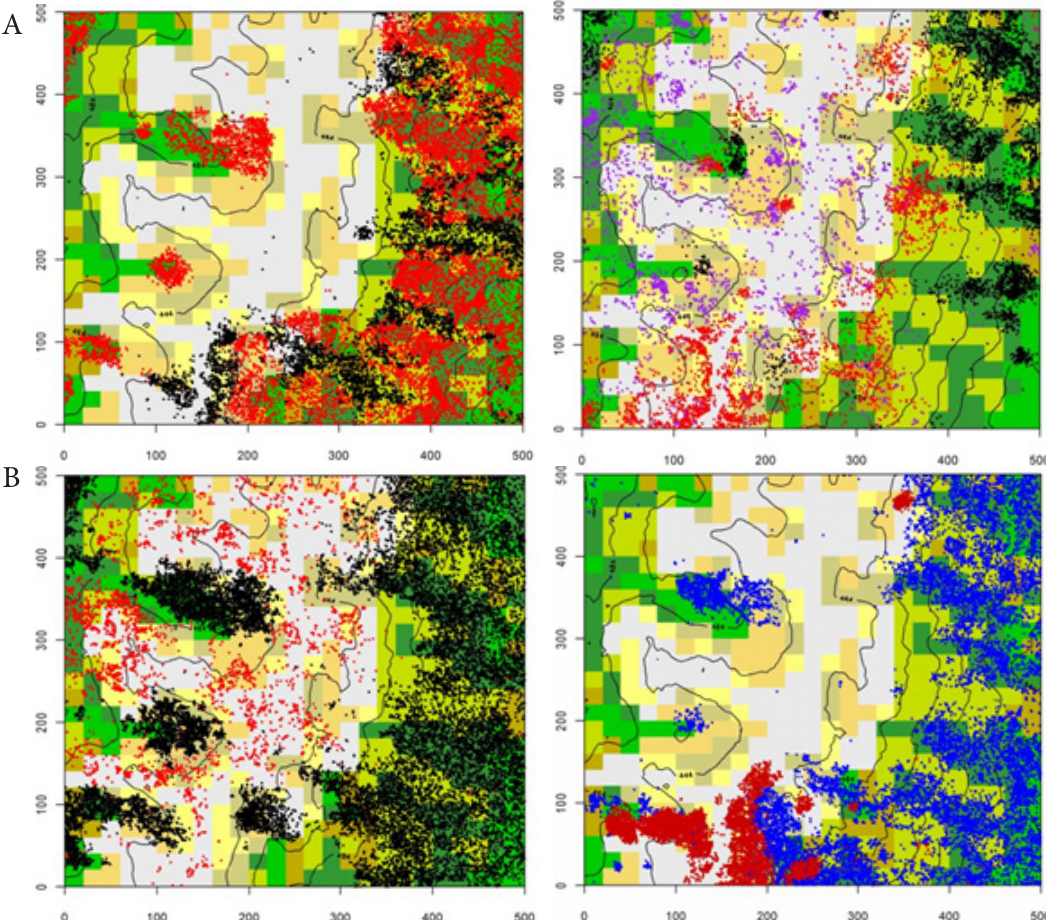
Figure 7: Spatial patterns of canopy (A) ( Mesua spp . [left], Shorea spp . [right]) and, subcanopy and treelet (B) ( Schumachaeria & Humboldtia spp . [left] and Agrostistachys spp. [right]) in the 25 ha Forest Dyanamics Plot in the Sinharaja World Heritage Site, Sri Lanka exhibiting strong habitat associations among closely related and co-occuring species (from Gunatilleke et al .,